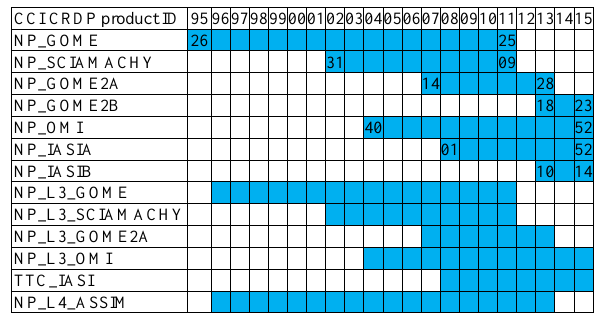
Table 2. Time coverage (up to 2015) of the nadir ozone profile data products generated and delivered in the Ozone_cci CRDP (numbers indicate start and end weeks for L2